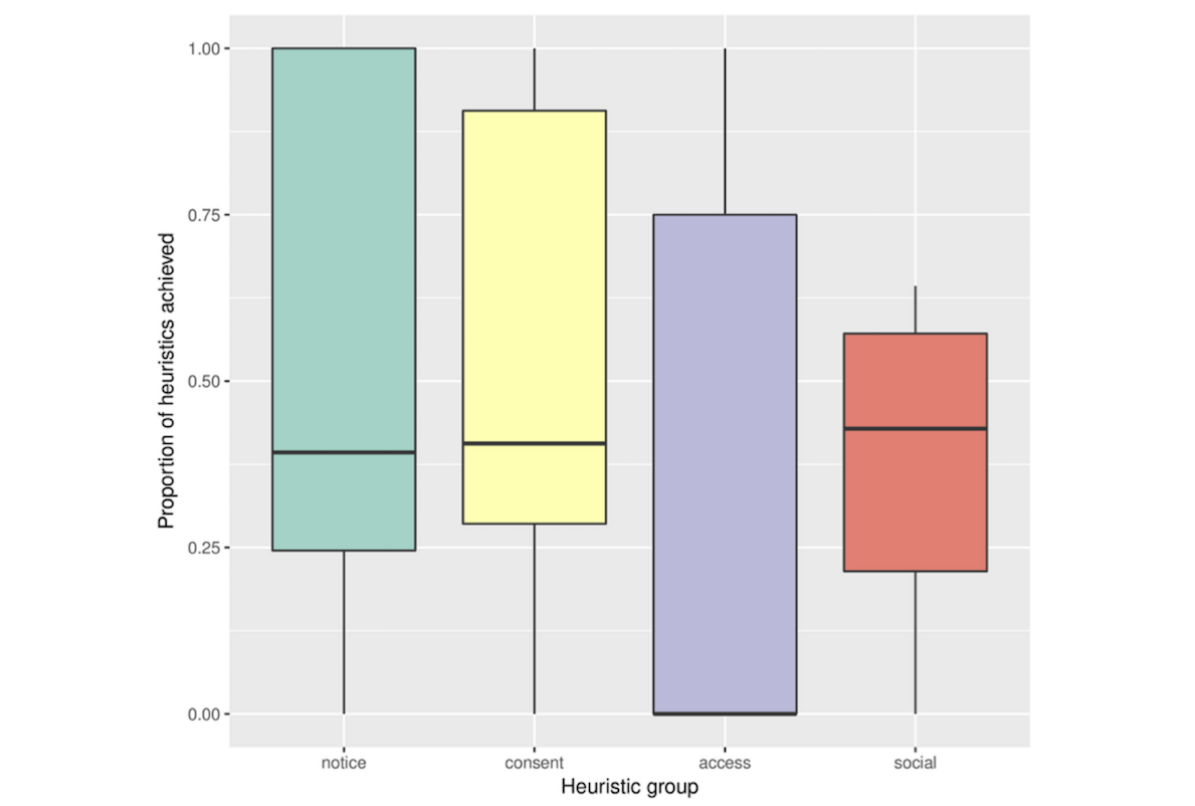
Figure 4. Boxplot showing the differences in performance among the 4 groups of